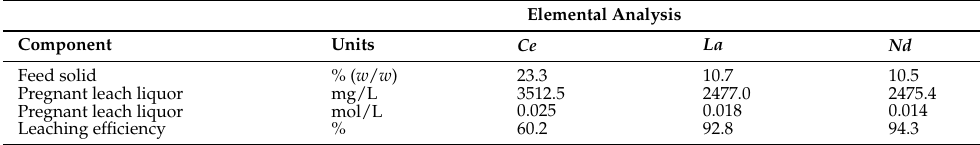
Table 4. Chemical analysis of pregnant leach liquor was obtained under the conditions evaluated.